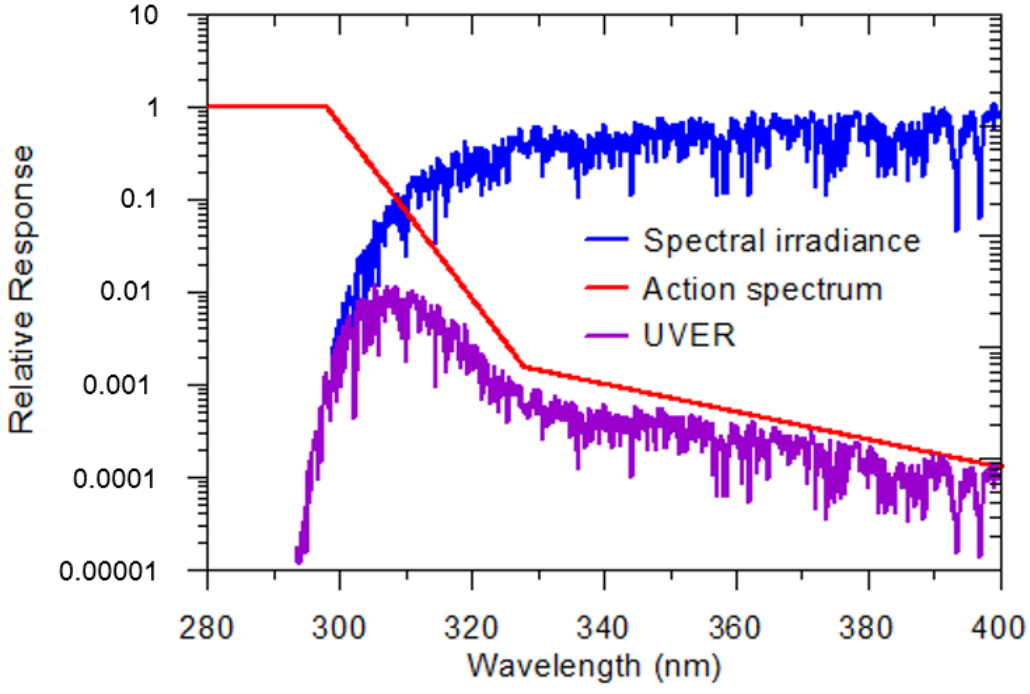
Figure 1. Normalized erythema action spectrum, (red), spectral irradiance on the surface (blue), and spectral ultraviolet erythemal radiation (UVER) irradiance (purple).